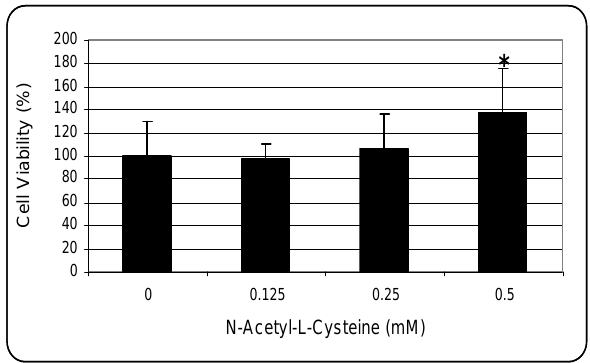
Figure 2: Effect of n-acetyl-l-cysteine (NAC) to human hepatocellular liver carcinoma (HepG were cultured with different doses of NAC for 48 hours as indicated in the Materials and Methods. Cell viability was determined based on the MTT assay. Each point represents a mean value and standard deviation of 3 experiments with 6 replicates per dose.